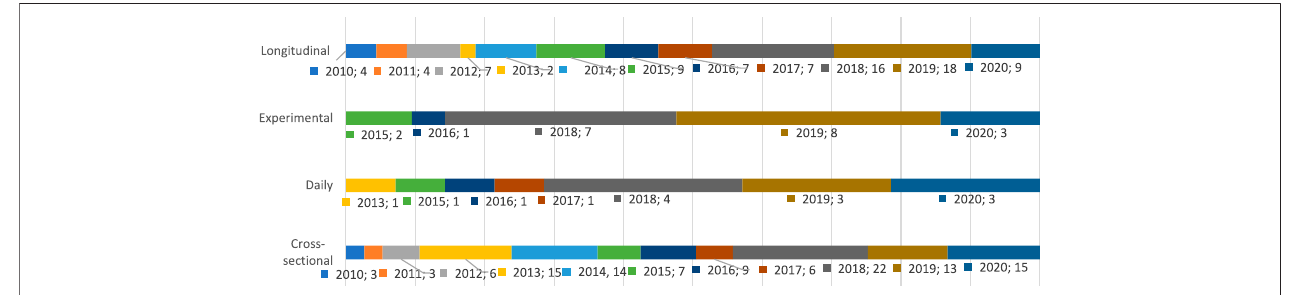
FIGURE 6 | Number of studies using different study